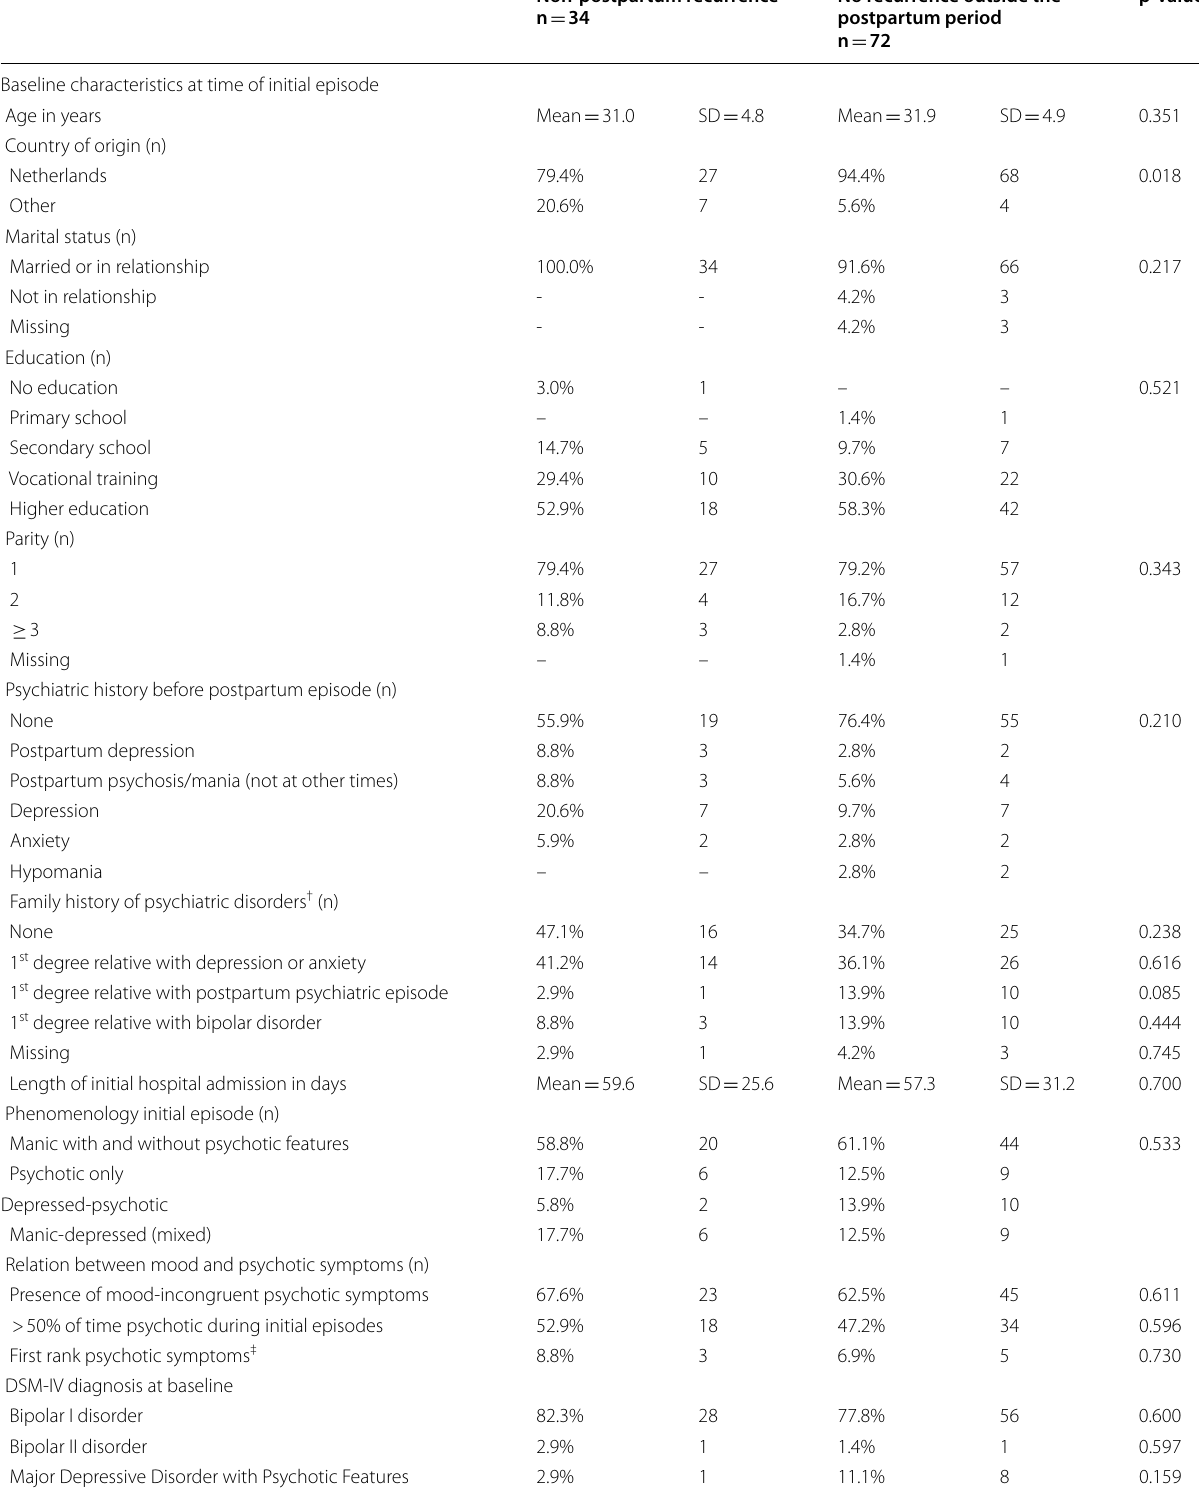
Table 1 Demographics and clinical characteristics of women with non‑postpartum recurrence during follow‑up and of women with no recurrence outside the postpartum period during